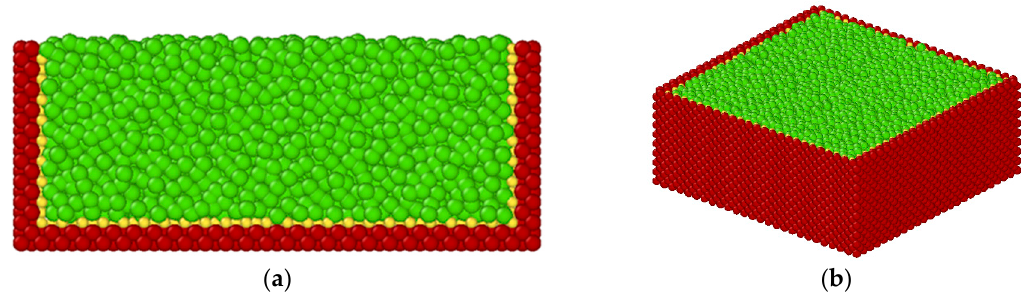
Figure 2. Molecular Dynamics Simulation Model of the Laser Beam Micromachining (LBMM) Process on Copper Substrate ( a ) Sectional view ( b ) 3-Dimensional view.